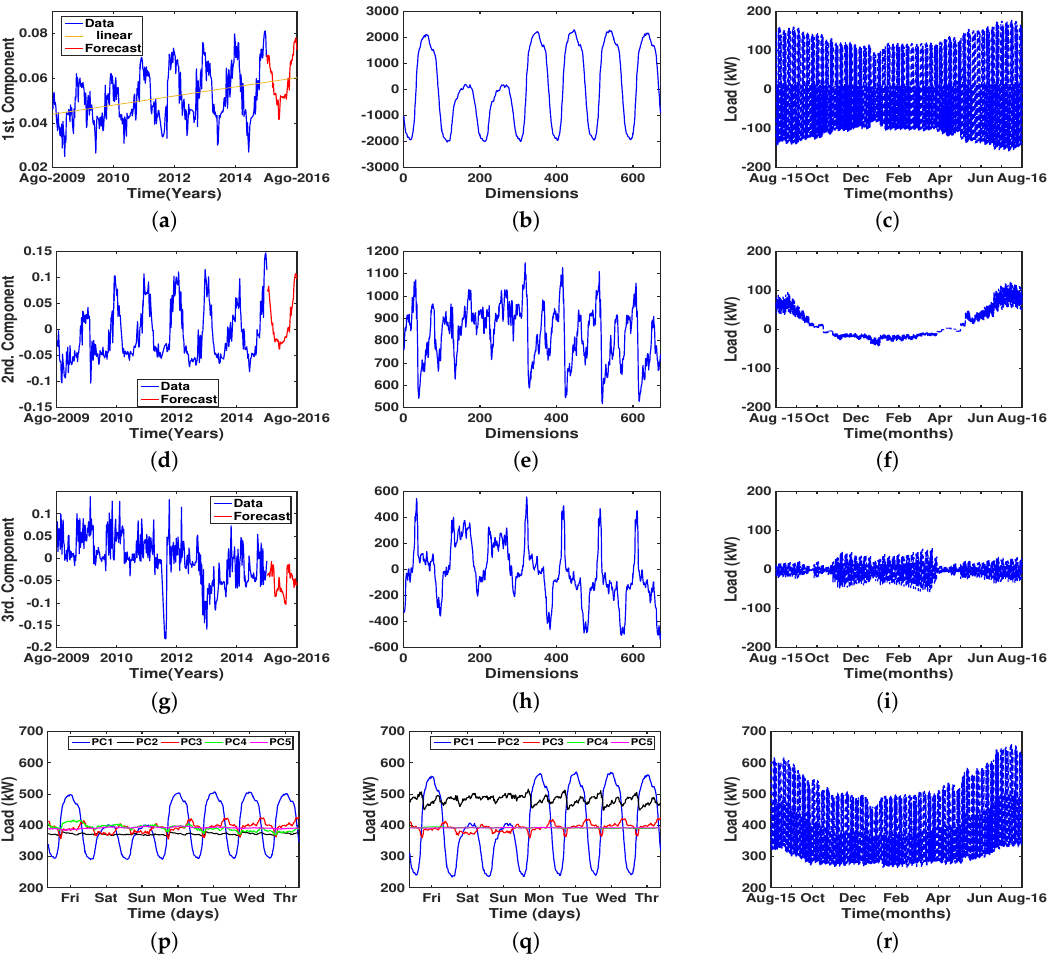
Figure 5. Principal component analysis (PCA) load prediction in Hospital Universitario de Fuenlabrada (HUF). For the the first, second, and third components, panels show the projection coefficient over the year ( a , d , g ), the eigenvector corresponding to the contribution of that component ( b , e , h ), and the yearly reconstructed partial load with that component ( c , f , i ). Panels ( p , q ) show two different reconstructed weeks in the two different periods, and ( r ) shows the reconstructed load with the first five